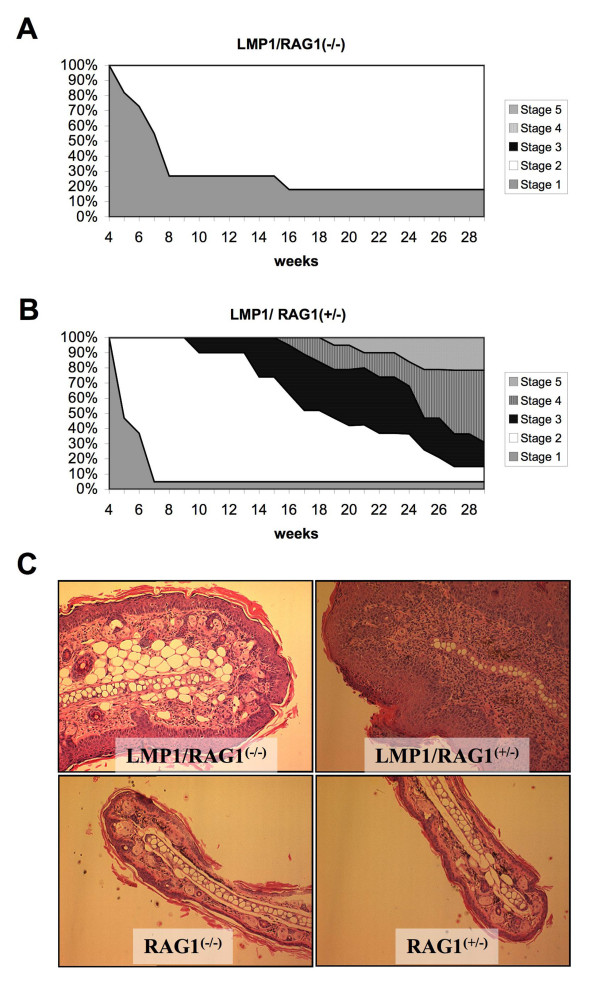
Phenotype limitation in a B/T-cell deficient background. A and B: Two cohorts of LMP1 transgenic mice, in either a RAG1 null (-/-), n = 11 (A) or RAG1 heterozygote, n = 18 (+/-) (B) background were monitored weekly (from 4-29 weeks old). The phenotypic stage of the ears of each mouse was recorded. Two dimensional area plots represent the percentage of mice at each ear stage (y axis) at weekly intervals (x axis). C: H&E staining of tissue sections from the ears of RAG1 null or RAG1 heterozygote mice in the presence or absence of the L2LMP1CAO transgene, as indicated. Original magnification: x100. Note, mice in this study were all 75% C57Bl/6/25% FVB strain.